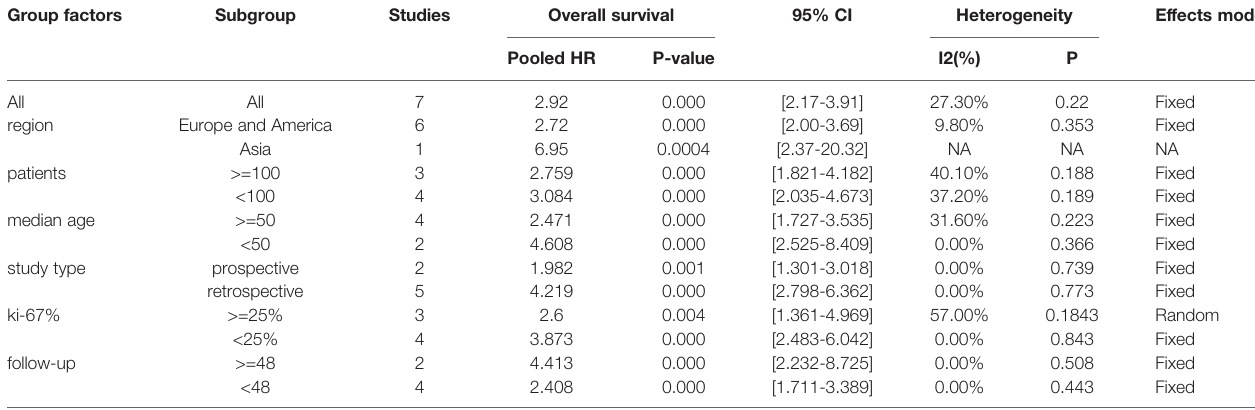
TABLE 4 | Subgroup analysis of pooled HR for melanoma patients with Ki-67 overexpression.